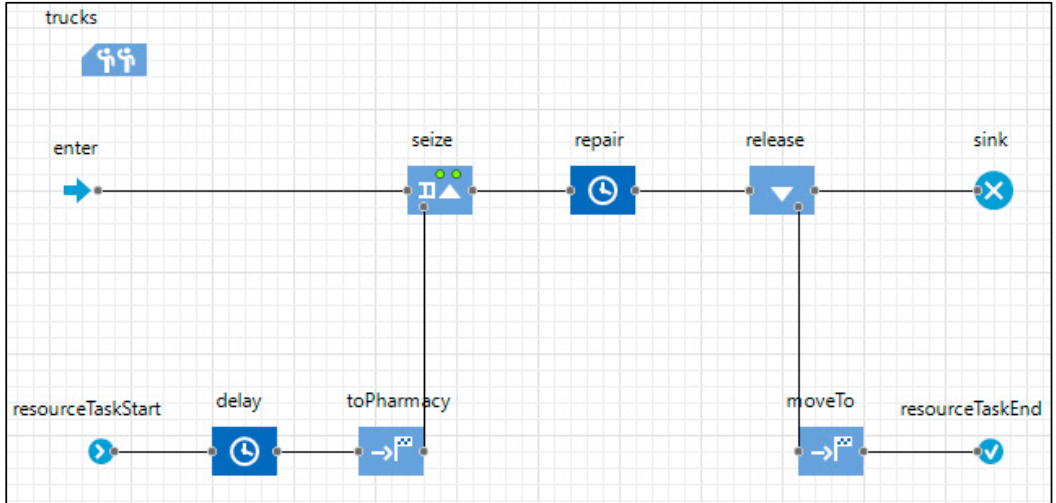
Figure 8. Discrete ‐ event simulation (DES) model in the manufacturing agent.